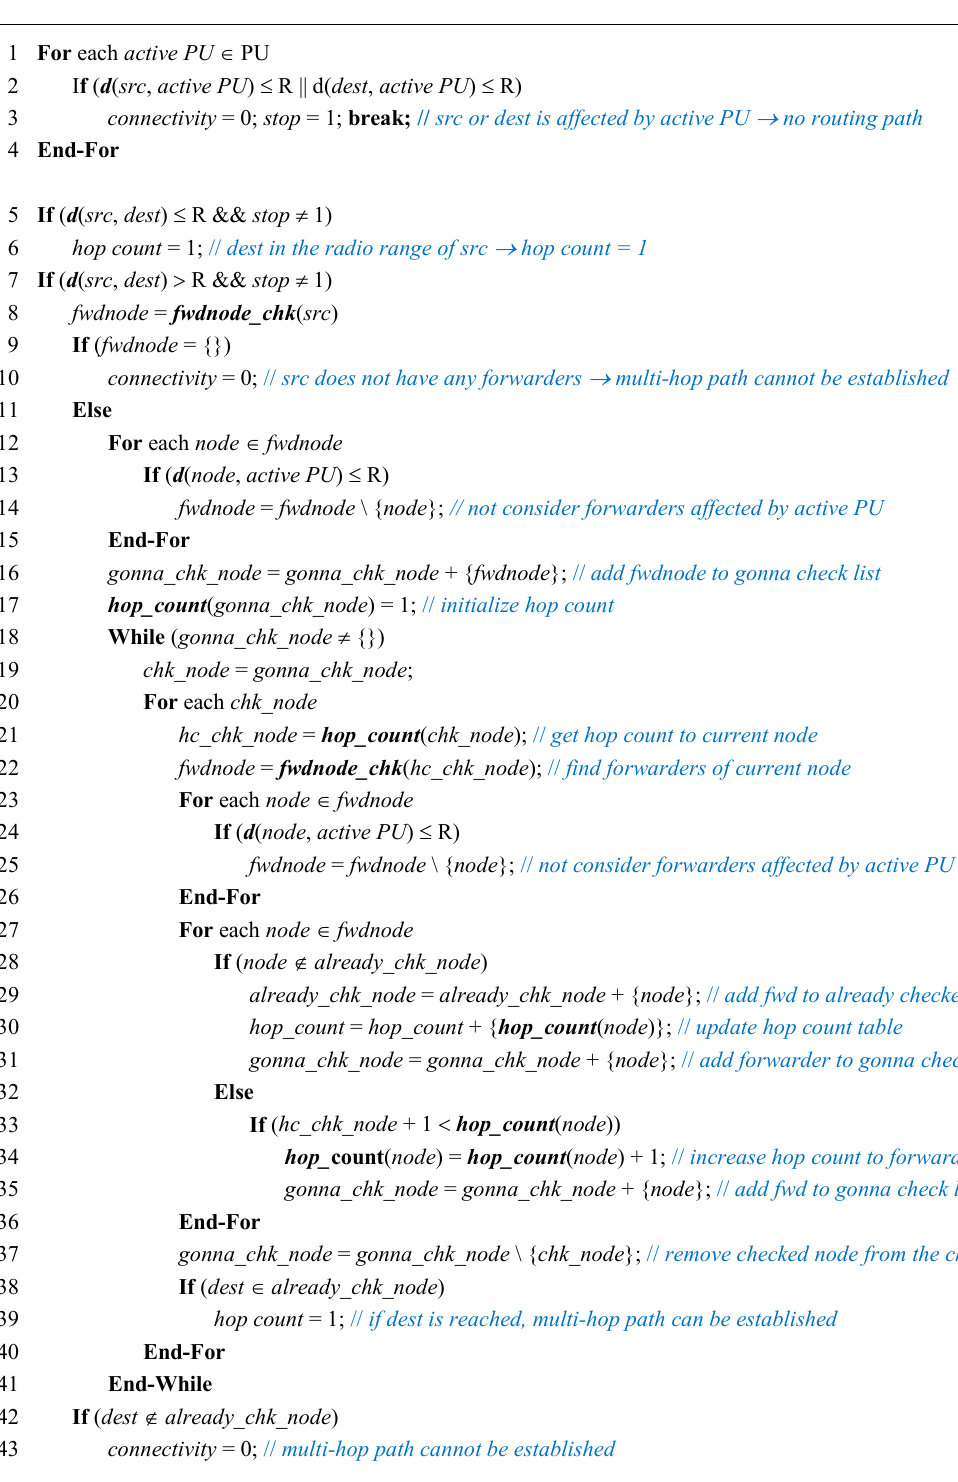
Figure 5. The pseudocode of our proposed algorithm to analyze the connectivity of multi-hop path between two arbitrary nodes in CRAHNs with given random wireless node